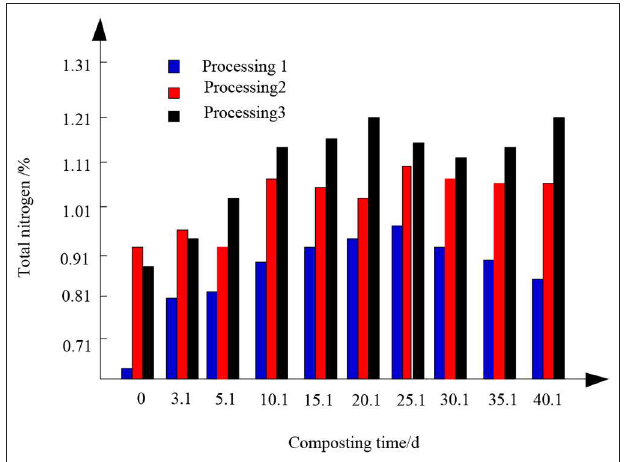
FIGURE 1 | Changes of total nitrogen content in different composting treatments.